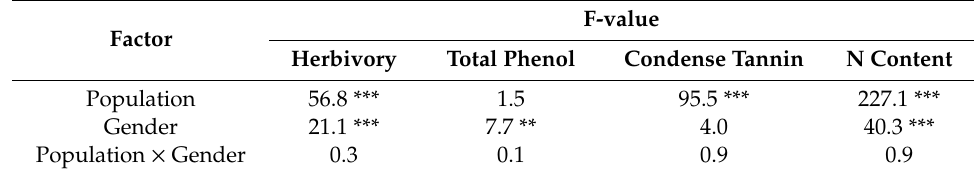
Table 5. ANOVA analysis of herbivory, N content, and chemical defense substance of willow plants. F-value Factor Herbivory Total phenol Condense tannin N content Population 56.8 *** 1.5 95.5 *** Gender Population × Gender 0.3